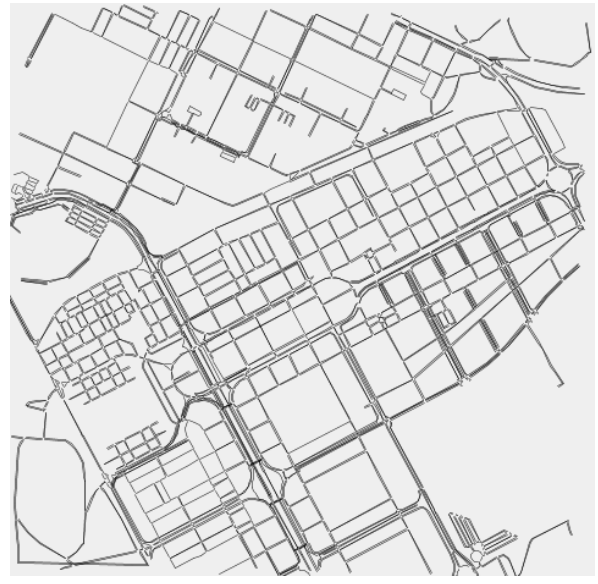
Figure 3. The VANET scenario considered for the simulations.